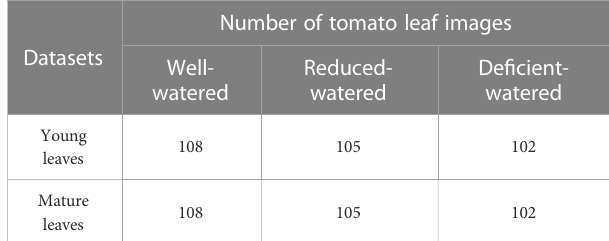
TABLE 1 Sample distribution under different water treatments.